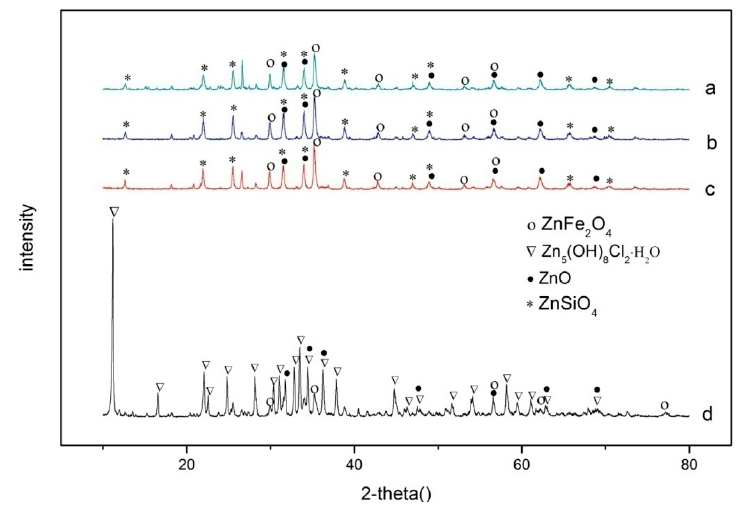
Figure 2. X-ray powder diffraction patterns of crude zinc oxide (C.Z.O.): ( a ) concentration of